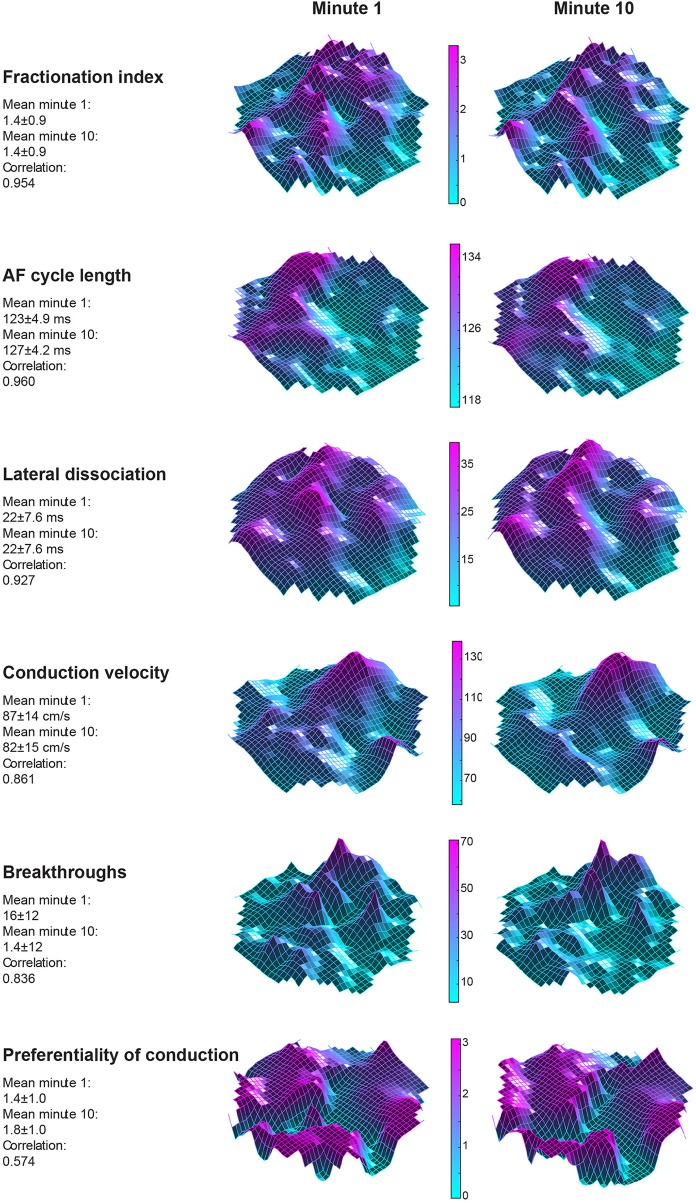
Spatial distribution of 6 AF parameters from goat 2. The left sided column represents property maps of the first 60-s-recording in a 10-min window. The right column depicts the final minute of the 10-min window. A high agreement for the absolute average of the maps was found between the maps. Interestingly, also a high degree of stationarity of spatial organization was found when the Pearson correlation coefficient (PCC) was considered. This was true for almost all parameters but weakest for preferentiality of conduction direction, suggesting highly variable conduction patterns.